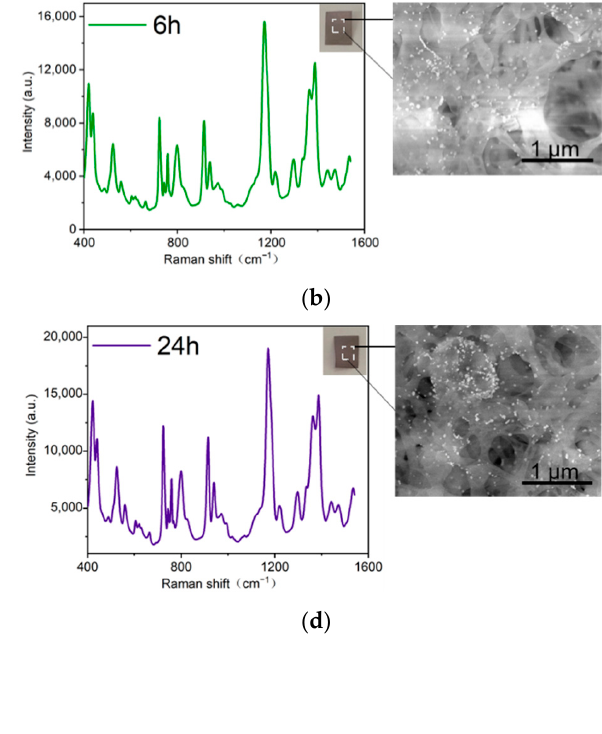
Figure 2. Characterization of the Au NP colloid. ( a ) The maximum single absorption peak of colloi- dal Au NPs is near 535 nm; ( b ) TEM image of Au NPs.